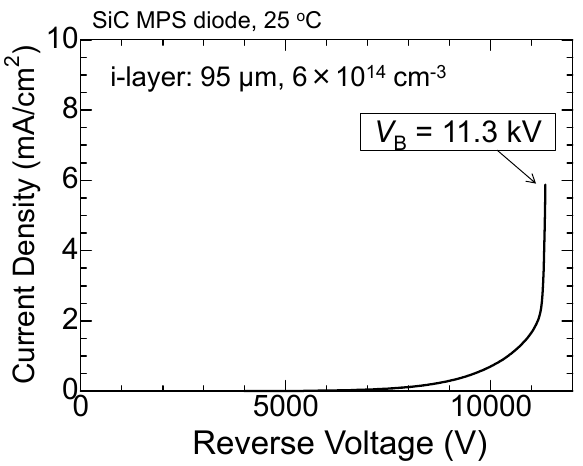
Figure 10. Reverse characteristic of a SiC epitaxial MPS diode fabricated in this study.